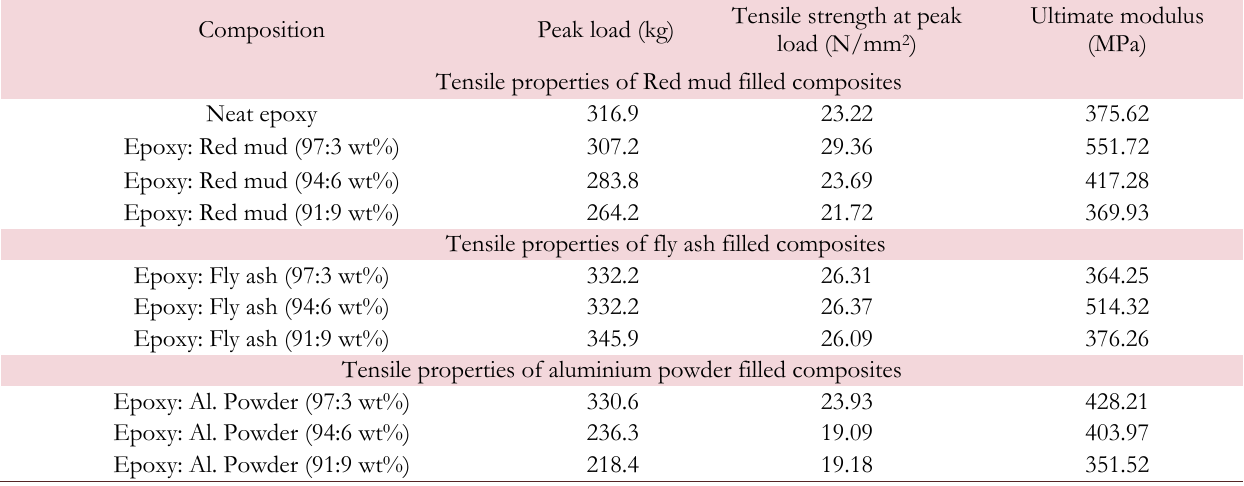
Table 4: Tensile properties of composites with different types of fillers.